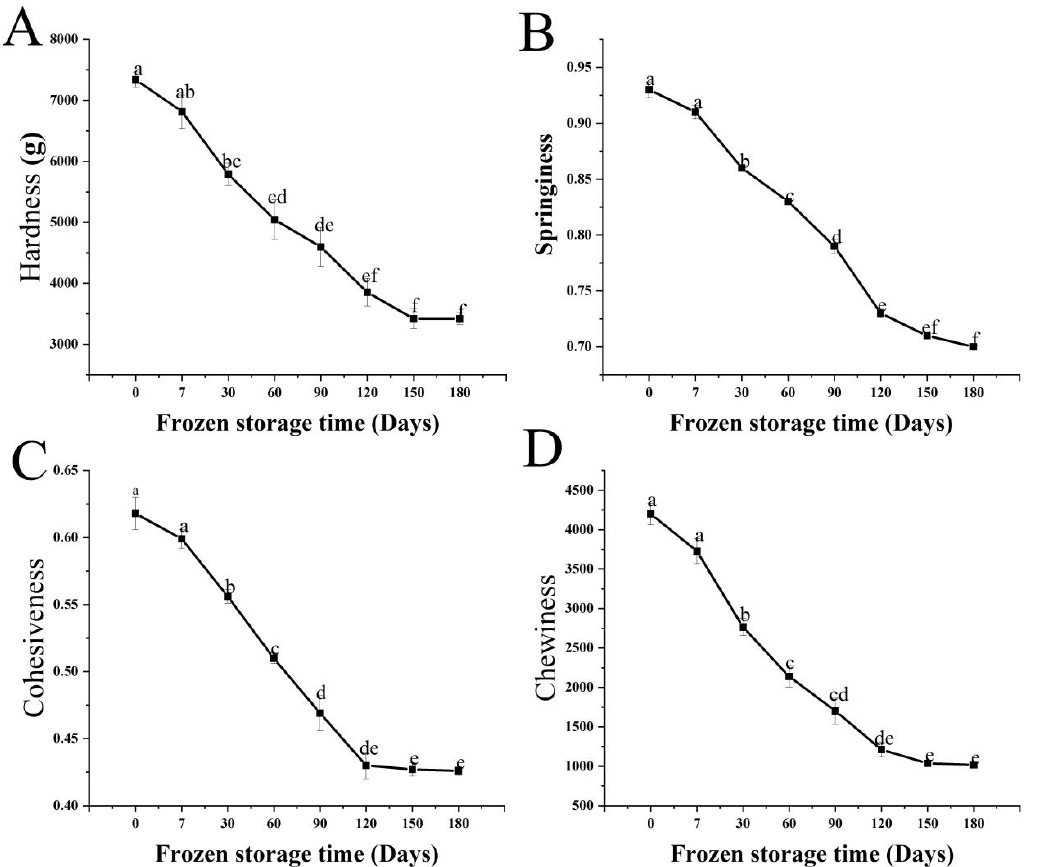
Figure 3. Changes in the hardness ( A ), springiness ( B ), cohesiveness ( C ), and chewiness ( D ) of fish sausages during frozen storage. Significant differences between samples ( p < 0.05) are denoted by lowercase letters.